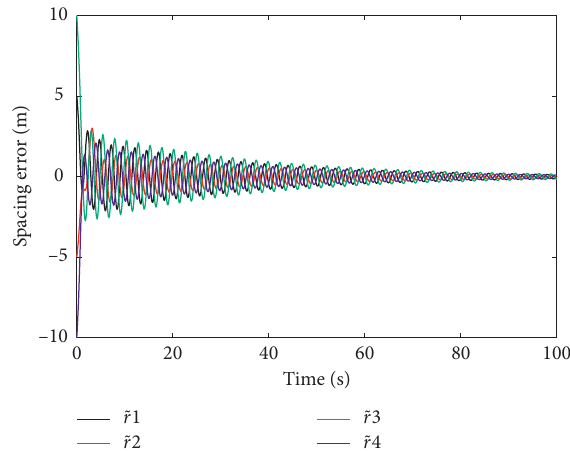
Figure 4: Spacing errors for an automated vehicular platoon under directed topology with τ � 0 . 33